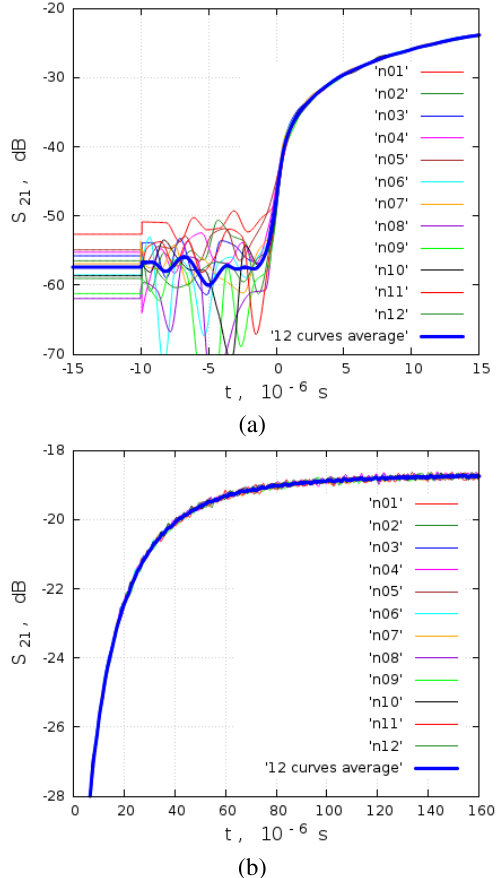
Figure 8: The S 21 ( t ) curve defined as an average of 12 syn- chronized up-switch traces when (a) − 15 µ s ≤ t ≤ 15 µ s and (b) 5 µ s ≤ t < 160 µ s.